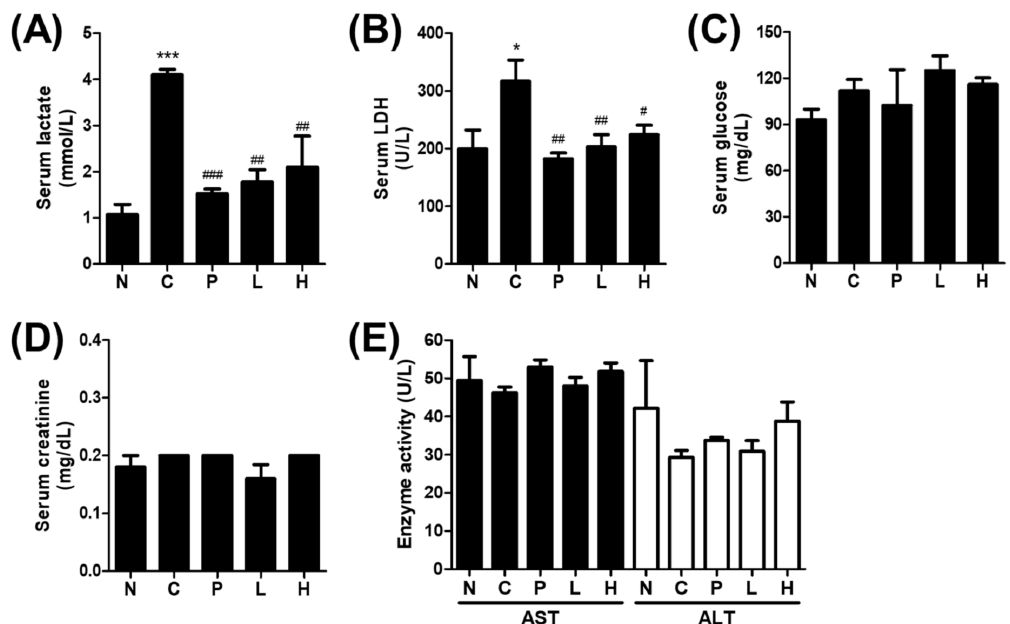
Figure 3. Measurement of physical performance-related factors. Serum levels of lactate ( A ), lactate dehydrogenase (LDH) ( B ), glucose ( C ), creatinine ( D ), and ( E ) aspartate transaminase (AST) and alanine aminotransferase (ALT) were measured by a commercially available assay kit. The results are shown as mean ± SEM. * p < 0.05 and *** p < 0.001 compared to the N group. # p < 0.05, ## p < 0.01, and ### p < 0.001 compared with group C. N; normal, C—control, P—positive control, L—low-dose S. officinalis , H—high-dose S. officinalis